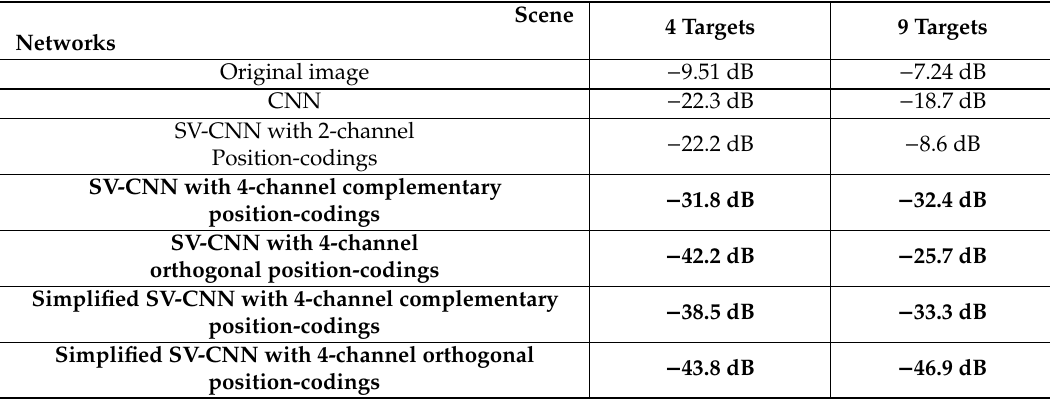
Table 1. MSLL comparison of the above networks.